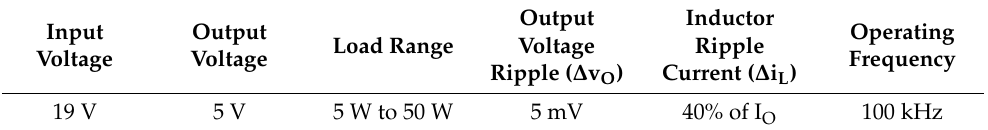
Table 1. Power section